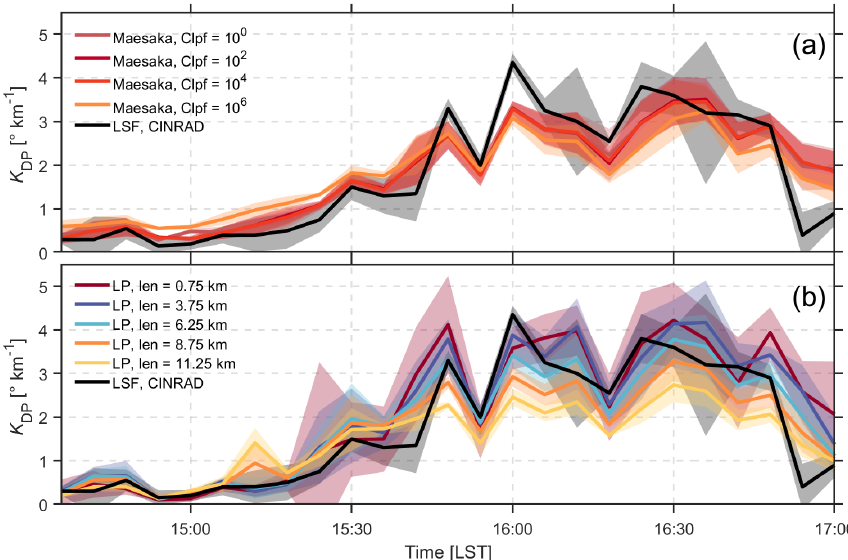
Figure 3. K DP estimates using (a) the Maesaka (2012) method and (b) LP over the Zhengzhou national reference climatological station. Thick lines and shaded areas indicate the respective median values and standard deviations of K DP at elevation angles of 1.5, 2.4, 3.3, and 4.3 ◦ . LP represents the linear programming method (Giangrande et al., 2013); LSF represents least squares fitting, which is the operational algorithm for CINRAD. Colored lines indicate the different window length (len) values used in